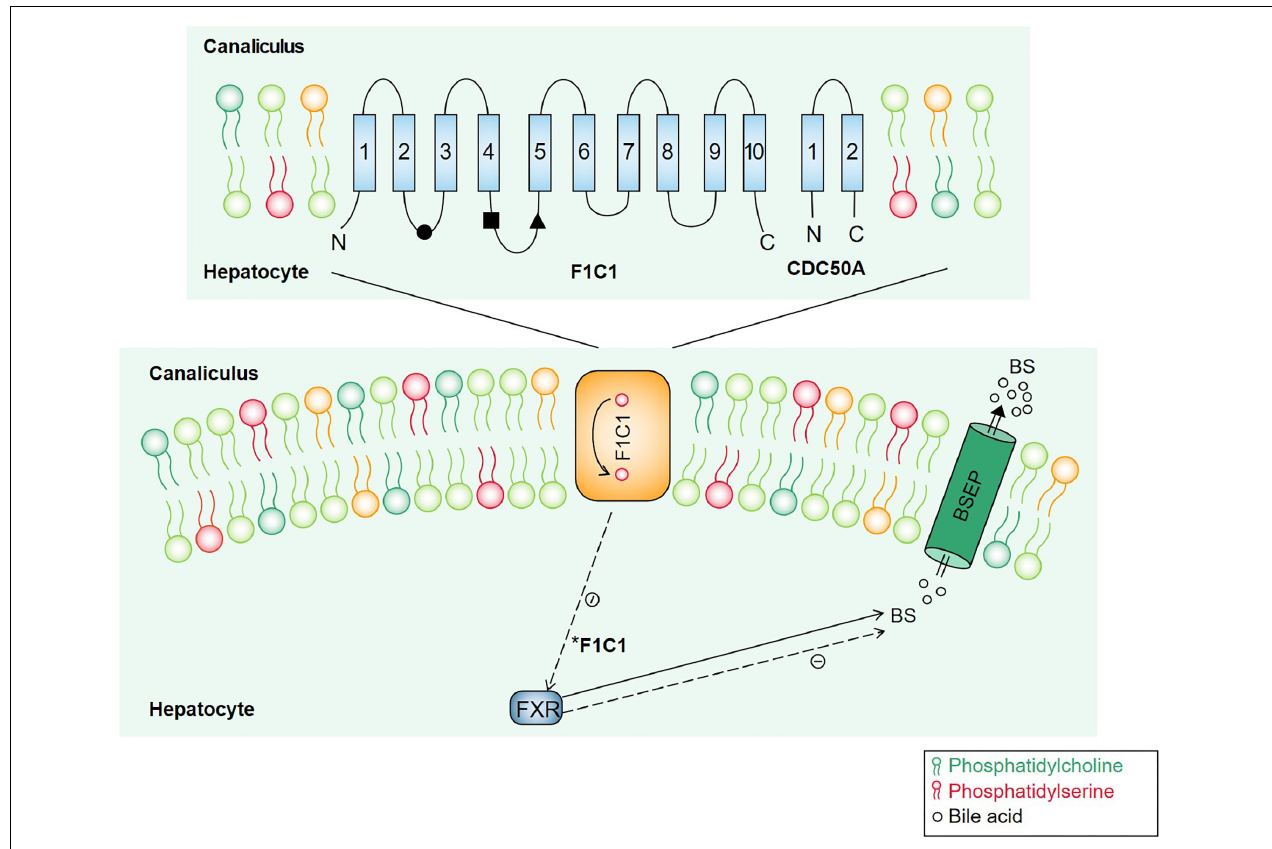
FIGURE 3 | Molecular mechanisms underlying cholestasis associated with ATP8B1 deficiency. ATP8B1 consists of 10 transmembrane segments, and ATP8B1 and CDC50A assemble to form a heterodimer complex that participates in PS flipping. BESP is a canalicular bile salt transporter. FXR is a nuclear receptor involved in regulating bile acid metabolism. When ATP8B1 is defective, the nuclear translocation of FXR is disrupted, and BSEP expression on the hepatic duct membrane is reduced due to its transcriptional inhibition. *Dotted line indicated a negative